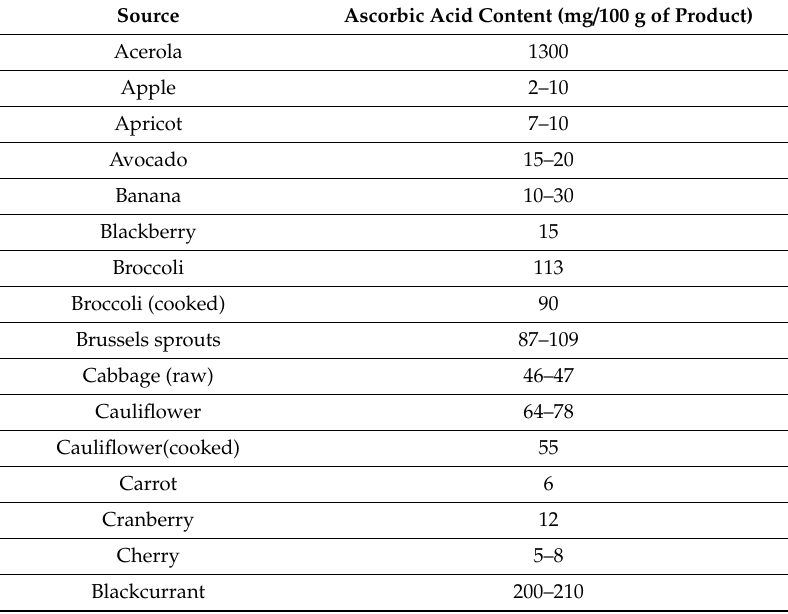
Table 3. Ascorbic acid content in fruit and vegetables (modified from